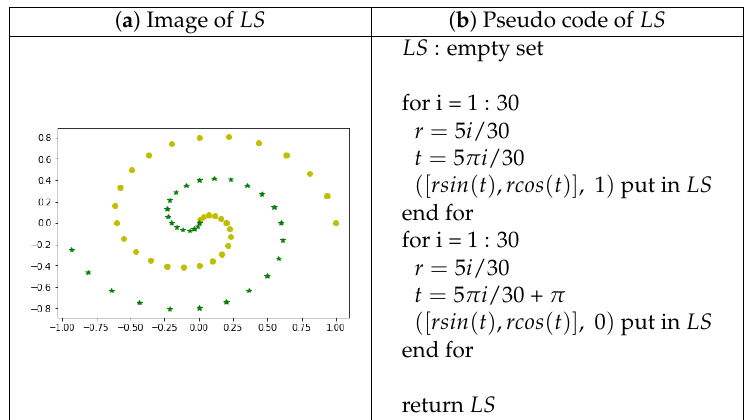
Table 3. Learning